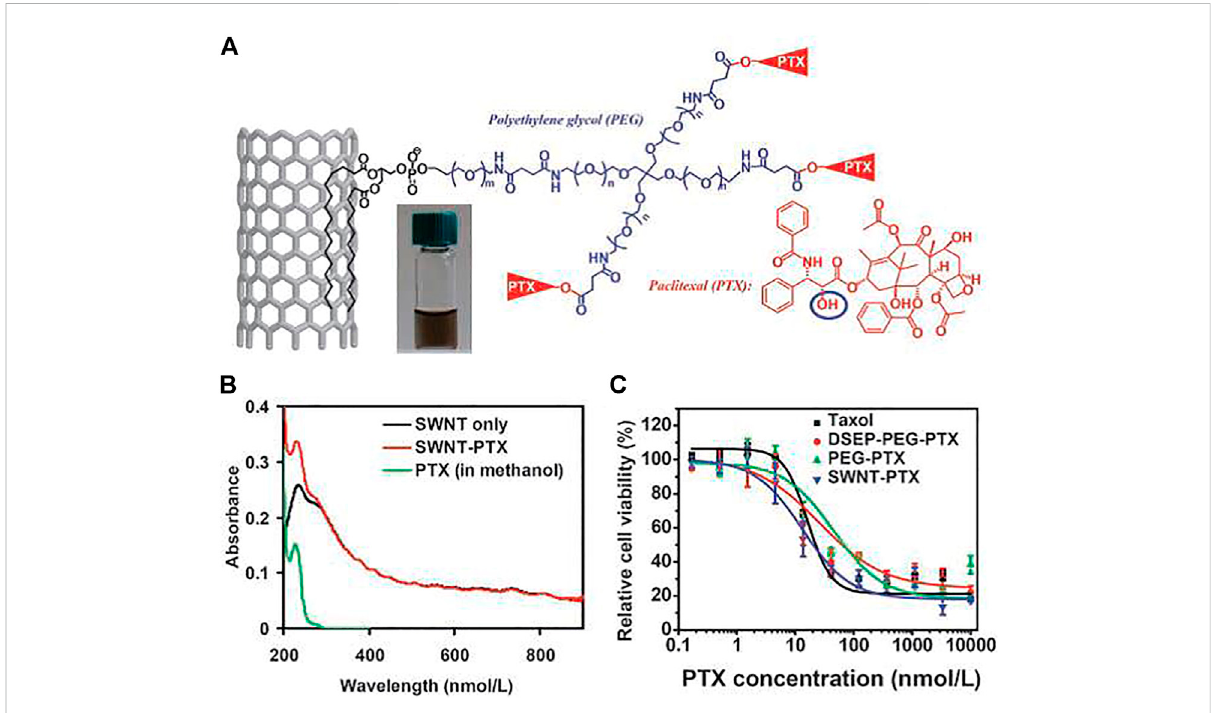
FIGURE 2 Carbonnanotube forPTXdelivery. (A) SchematicillustrationofPTXconjugation toSWCNT functionalizedbyphospholipids withbranchedPEG chains. (B) UV-VIS-NIRspectraofSWCNTbefore(blackcurve)andafterPTXconjugation(redcurve). (C) CellsurvivalversusconcentrationofPTXfor 4T1 cells treated with Taxol, PEG-PTX, DSEP-PEG-PTX, or SWNT-PTX for 3